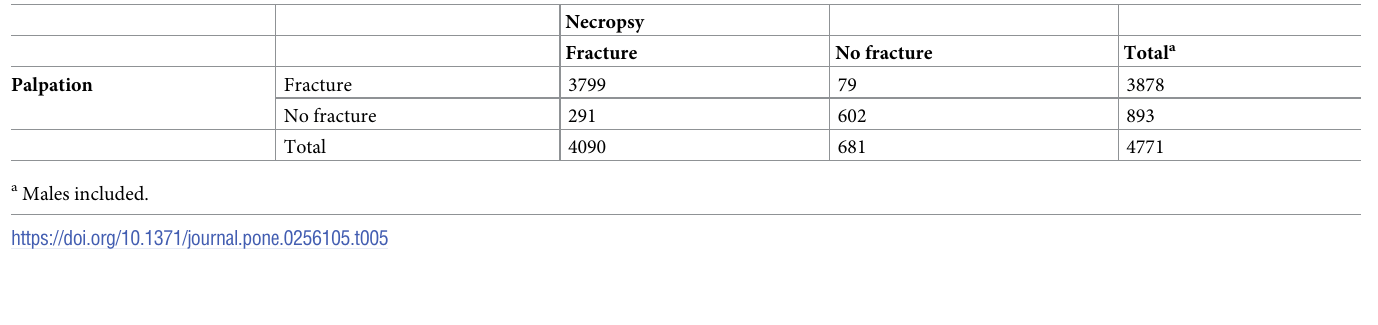
Table 5. Contingency table KBF detected by palpation and